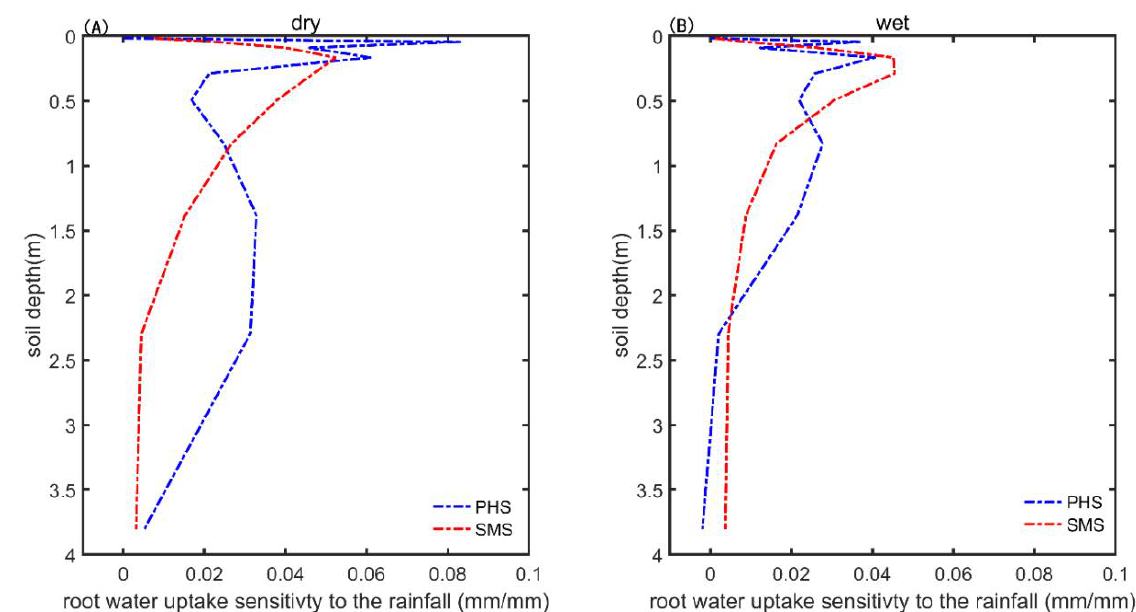
Figure 11. Drought sensitivity of root water uptake ( A ) depicts the sensitivity of root water uptake in each soil layer to precipitation in dry areas; ( B ) is the same as ( A ), but for wet areas. Sensitivity refers to the regression coefficient between root water uptake of each layer and precipitation.